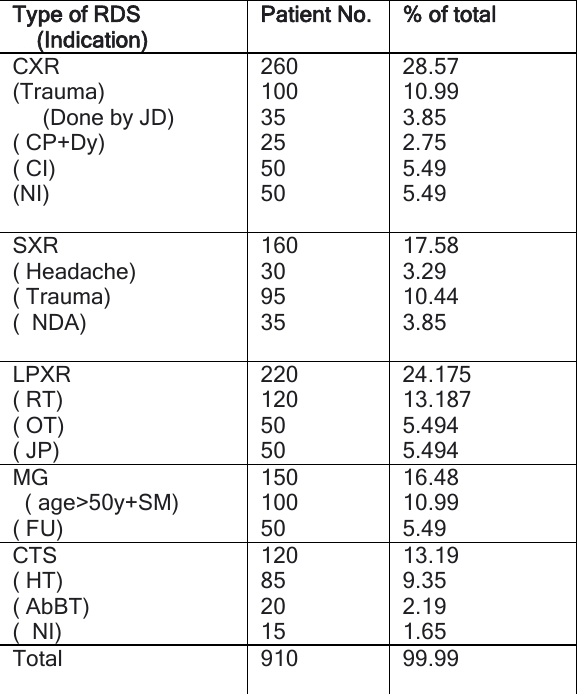
Table-3 Different causes for doing